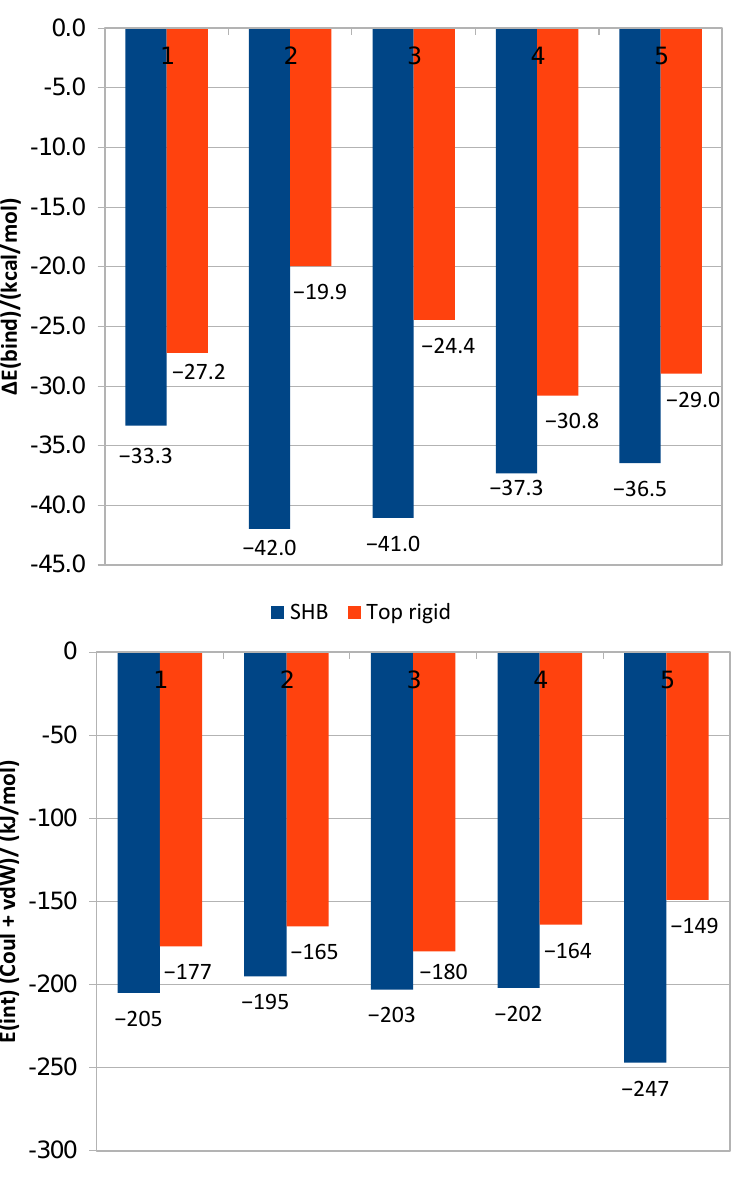
Figure 1. QM/MM binding energy and interaction energy graphs, score comparison between HSC (blue) and top rigid (Adt) conformation (red) for (1) pyrametostrobin; (2) pyraclostrobin; (3) pyribencarb; (4) famoxadone; and (5) enoxastrobin.